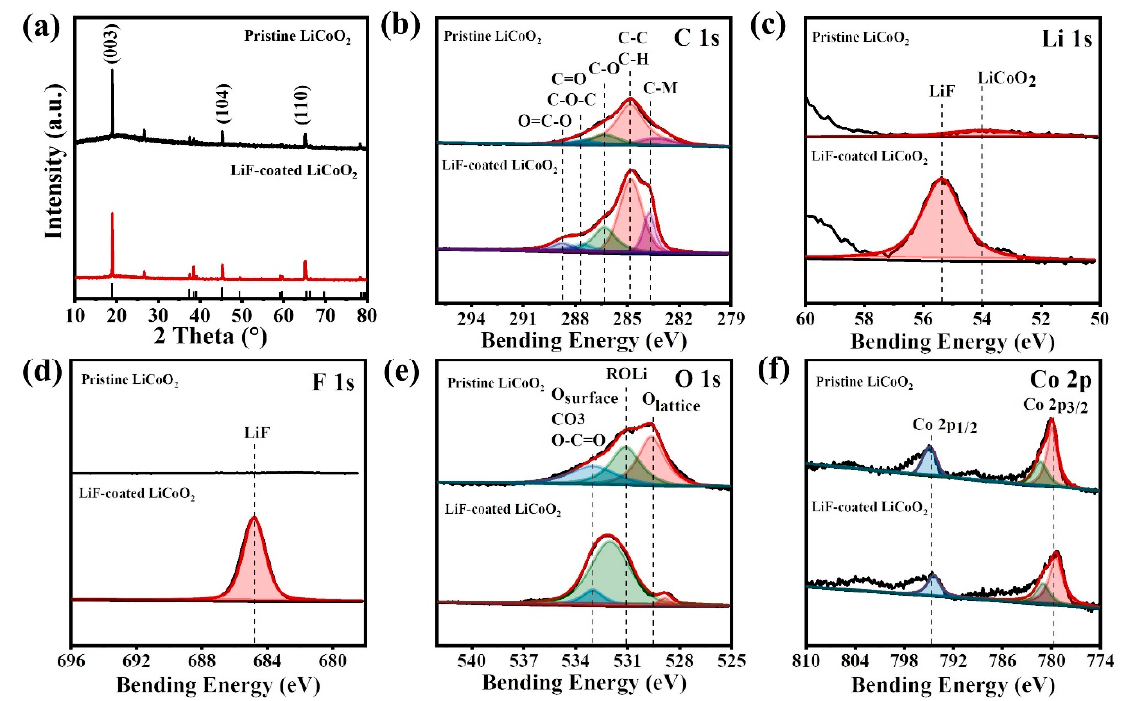
Figure 6. ( a ) the XRD of pristine LCO and LiF-coated LCO. ( b – f ) XPS spectra of the C 1s, Li 1s, F 1s, O 1s, and Co 2p photoemission lines collected from LCO and LiF-coated LCO electrodes.